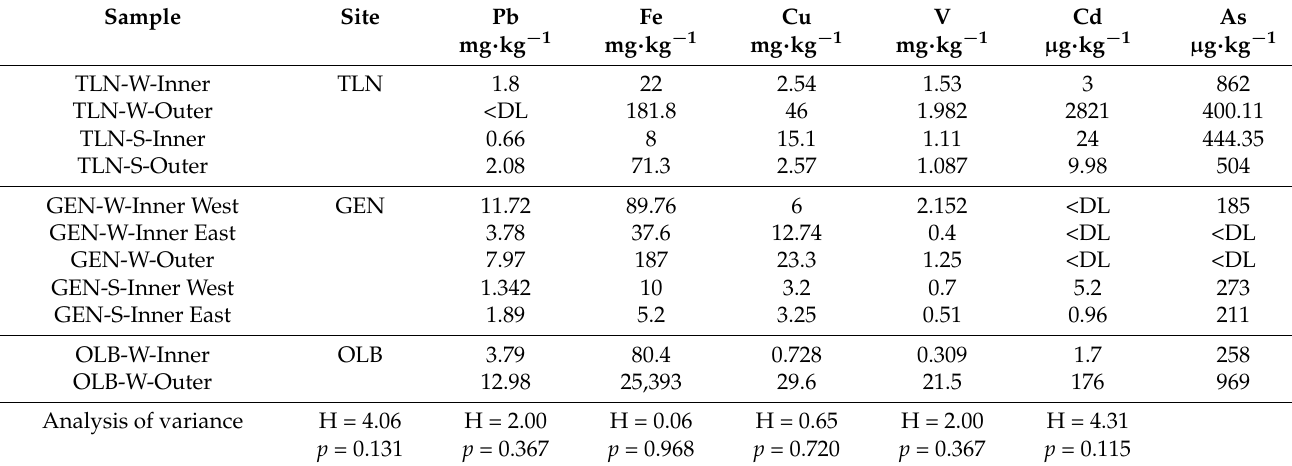
Table 2. Trace metal mass-related concentrations in biofilm extracted from microplastics at the different sites (TLN: Toulon, GEN: Genova and OLB: Olbia), seasons (W: winter and S: summer), zones (Inner and Outer). F = ANOVA’s Fisher statistics and p = p